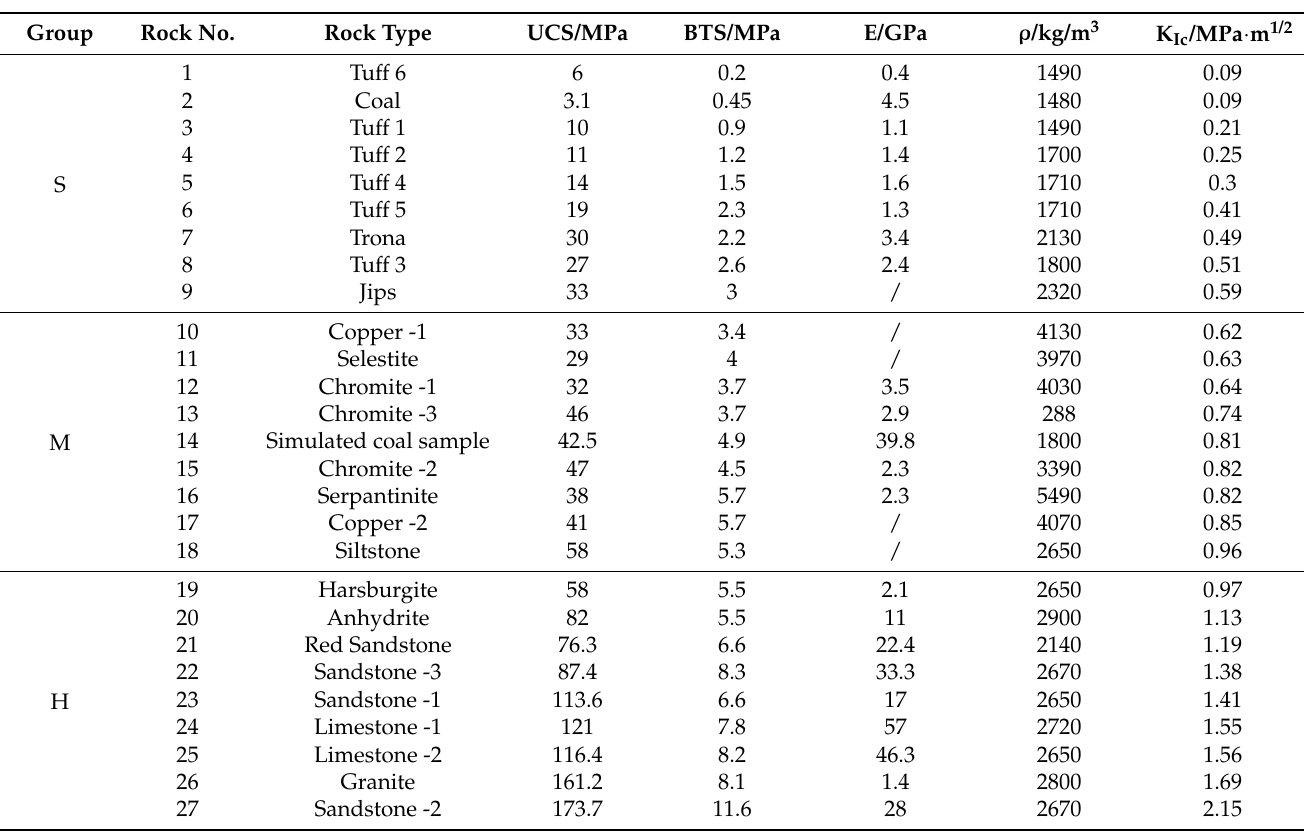
Table 1. Rock mechanical properties used in cutting